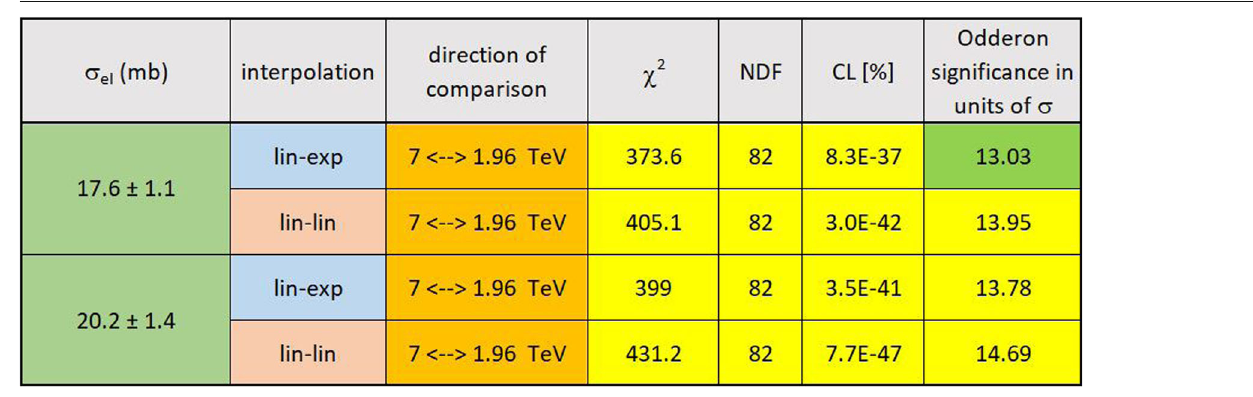
Table 4 Summary table of the search for an Odderon signal in the two- the previous Table 2, by adding the χ 2 and the NDF values of both way comparison, for the significance of an Odderon signal in the com- directions of the comparisons. These results are remarkably stable with √ s = 7 TeV, parison of the H ( x ) scaling functions of pp collisions at respect to the choice of the unknown integrated elastic cross section √ s = 1 . 96 TeV, and also with respect to the choice of the linear- at measured by the TOTEM experiment at the LHC, and p ¯ p elastic col- √ s = 1 . 96 TeV, measured by the D0 experiment at Teva- lisions at exponential or linear-linear interpolations. This effectively indicates that the combined significance of the Odderon discovery is at least tron. This table indicates that the Odderon signal is observed with at least a 13 σ significance, when both projections are combined from